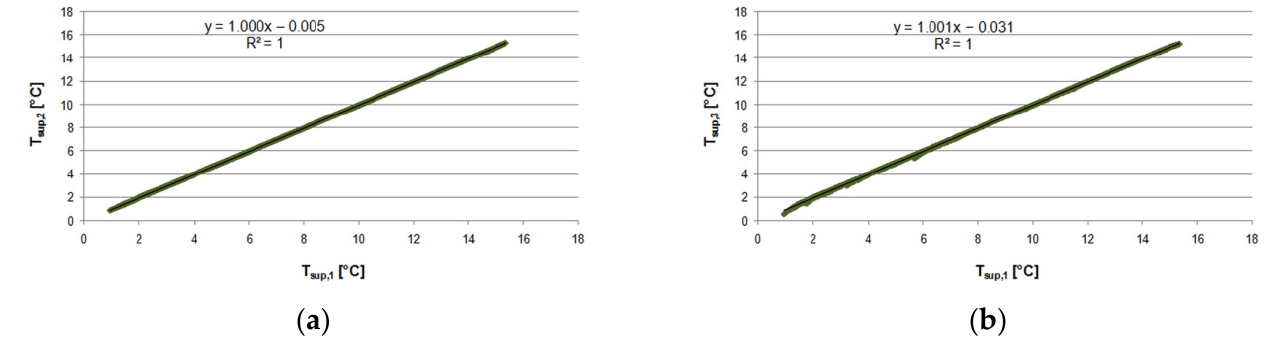
Figure 12. Hourly outlet air temperature from EAHE from method (1) and: ( a ) method (2); ( b ) method (3).